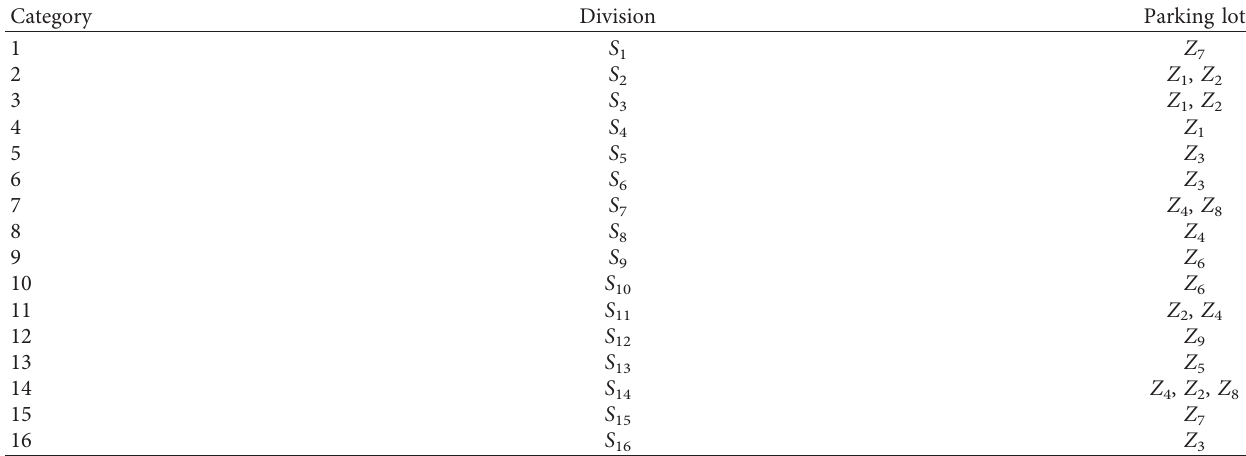
Table 6: Manner by which staff use different parking lots.